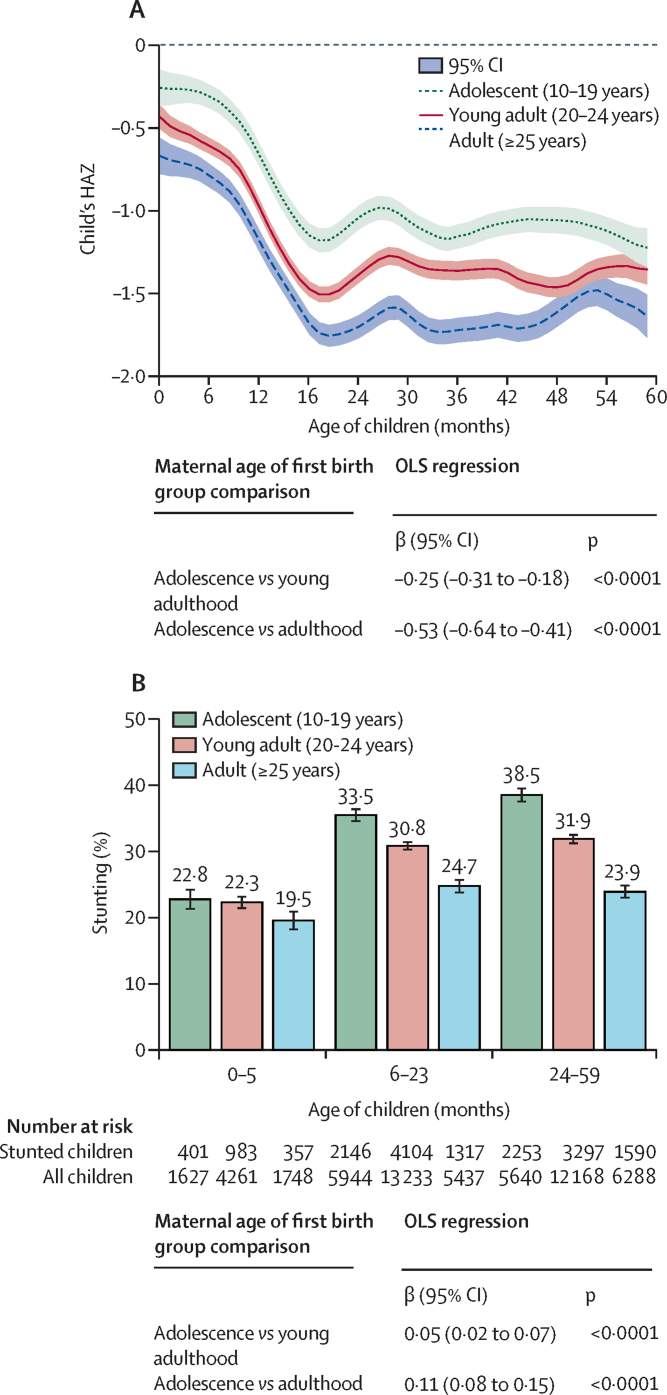
HAZ score and prevalence of stunting for first-born children by child's age and mother's age at first birth in India, 2016(A) HAZ score. Curves are smooth local polynomials with 95% CIs. (B) Stunting. Adjusted coefficient (95% CI) for models are shown below each panel in the figure. OLS regression models were adjusted for child age, sex, maternal religion, and caste fixed effects and controlled for the cluster sampling design and sampling weights used in the survey. Data are from India's fourth National Family Health Survey (NFHS-4, 2016).16 HAZ=Length or height-for-age Z score. OLS=ordinary least squares.